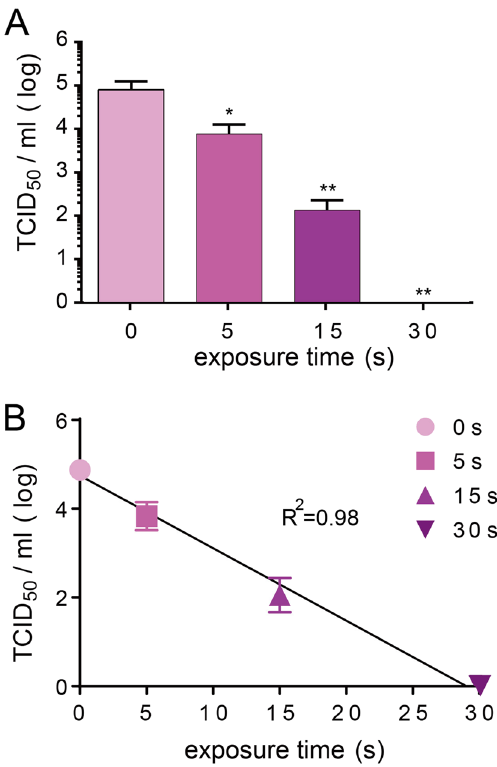
Figure 2. Effect of ultraviolet C (UVC) irradiation on severe acute respiratory syndrome coronavirus 2 (SARS-CoV-2) infectivity. ( A) Change in 50% tissue culture infective dose (TCID 50 ) of SARS-CoV-2 after UVC irradiation. SARS-CoV-2 (5 mL) with a titer of 5 × 10 4 TCID 50 /mL was irradiated with a UVC light tube for 0, 5, 15 or 30 s and then was titrated using the TCID 50 assay with Vero E6/TMPRSS2 cells. Assays are in triplicate and values represent the mean ± standard deviation (SD) of three replicates. Significance has been determined using one-way analysis of variance followed by Dunnett’s multiple comparisons test. The asterisk indicates a statistical difference (* p < 0.05; ** p < 0.01). ( B) Linear regression analysis to examine the correlation between UVC exposure time and SARS-CoV-2